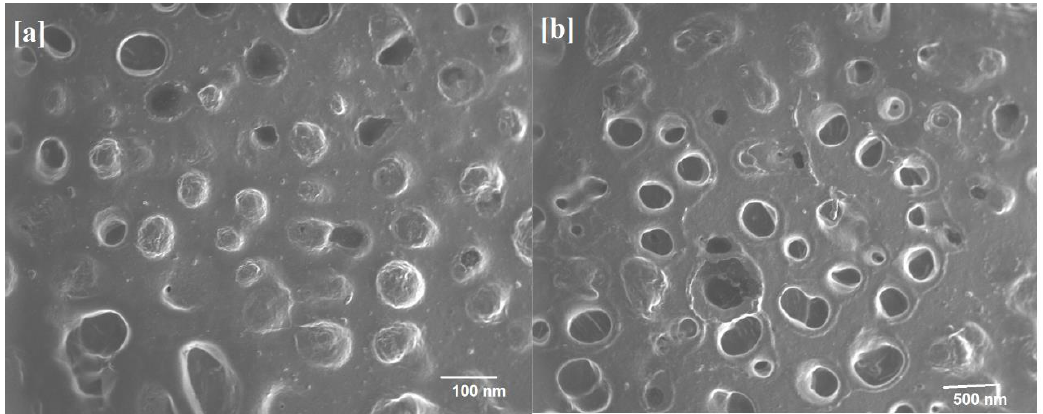
Figure 1. ( a ) SEM photograph of selected S3 and ( b ) size-measured